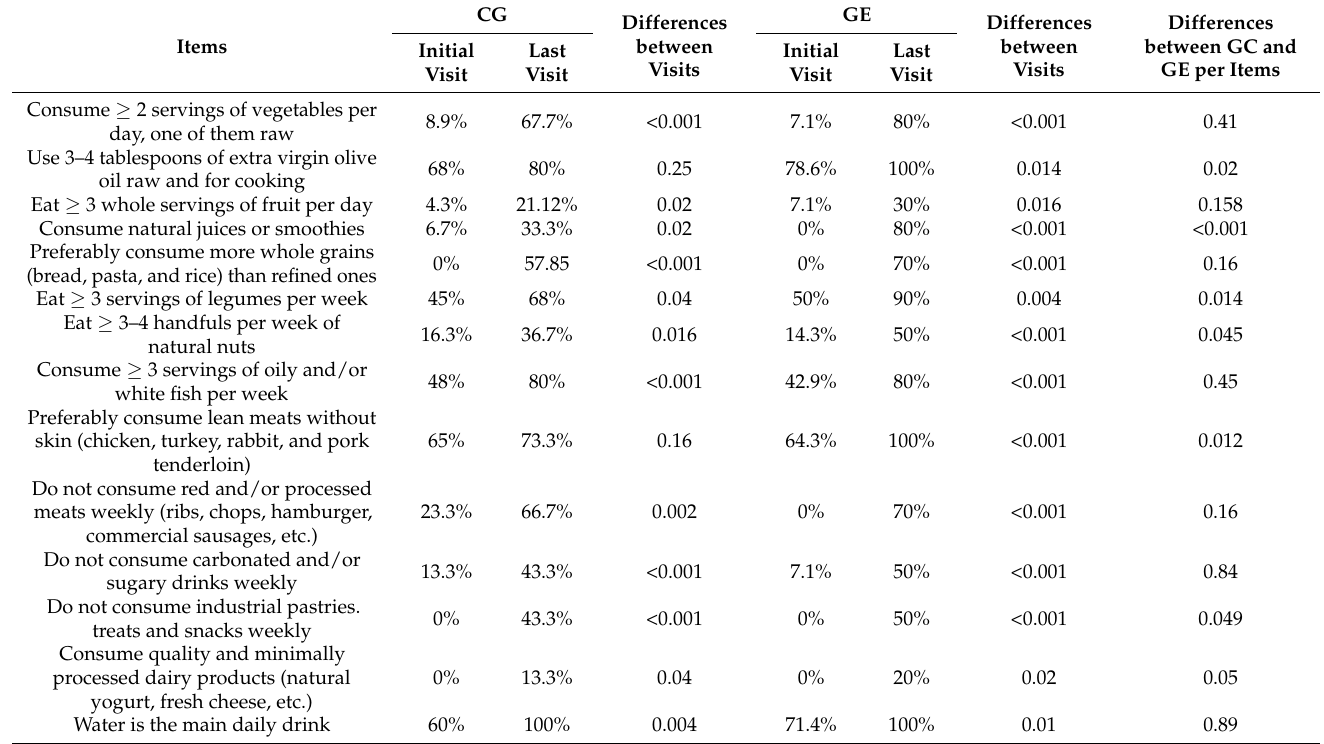
Table 3. Percentage of compliance with each item included in the decalogue of healthy eating after visit